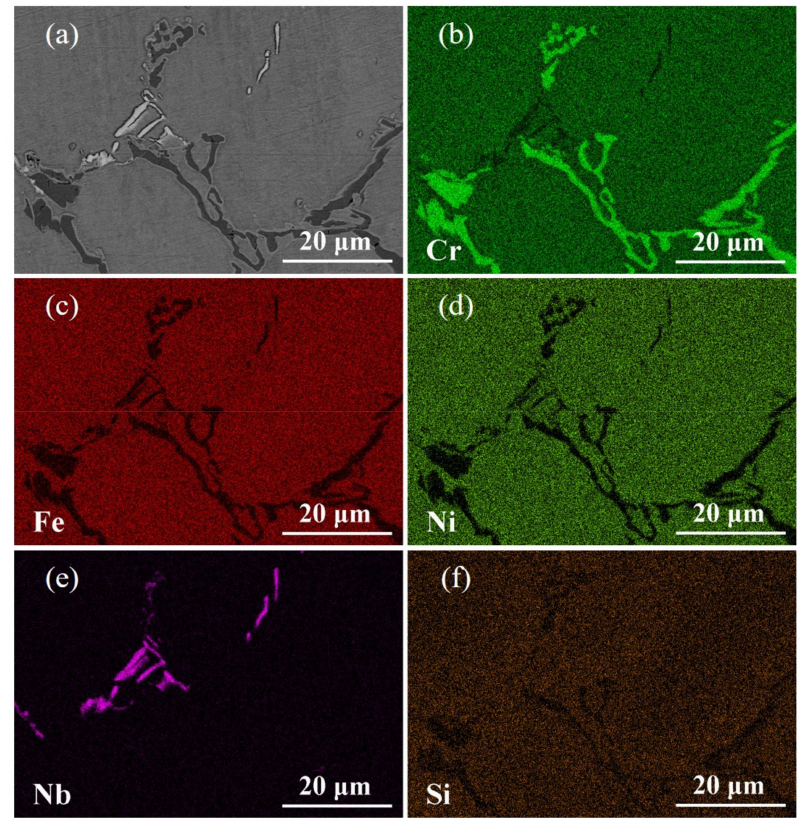
Figure 5. Precipitations of as-cast HP40Nb alloy detected using SEM elemental mapping: ( a ) SEM image, ( b ) Cr, ( c ) Fe, ( d ) Ni, ( e ) Nb and ( f ) Si